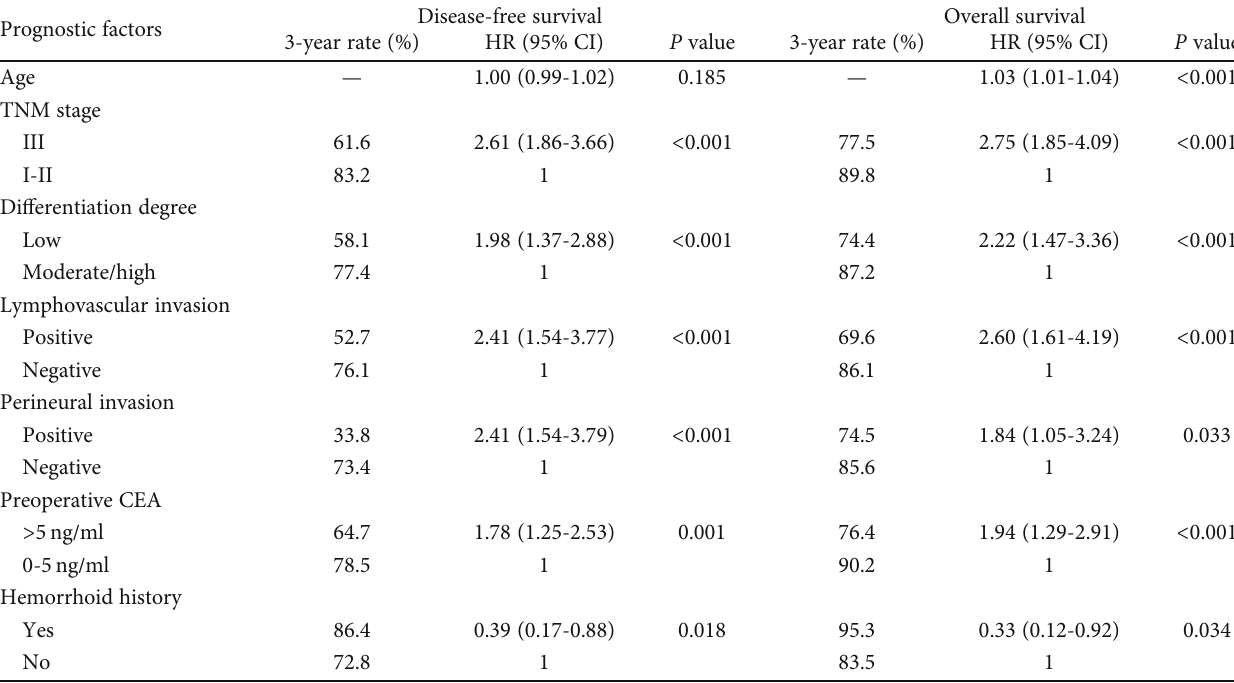
Table 3: Univariate analysis of prognostic factors for DFS and OS.